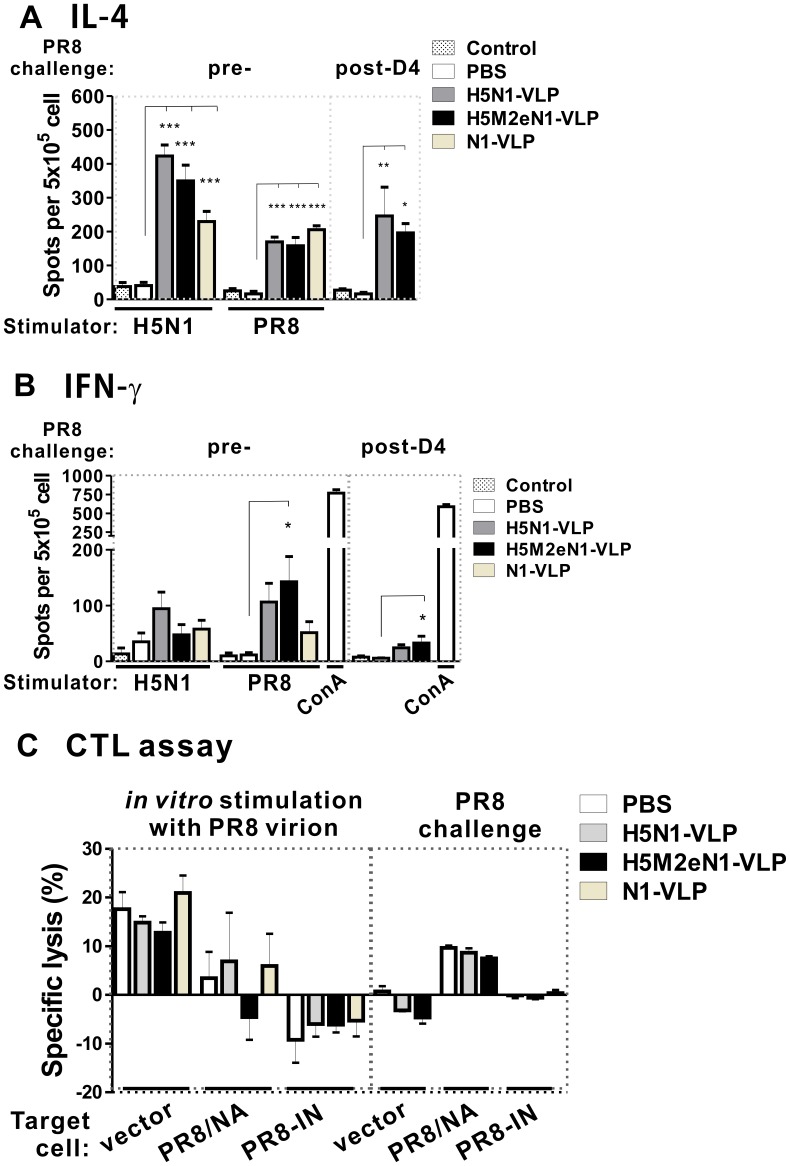
T helper cell responses in VLP-vaccinated mice.The level of IL-4 (A) and IFN-γ (B) spot-forming cells/5×105 in spleens of mice was determined by ELISpot assay. Mice groups (n = 5) were immunized as described in the text either with 15 µg of VLPs vaccines or mock-treated (PBS). Splenocytes were stimulated in vitro with BEI-inactivated whole viruses of H5N1 (10 µg/mL), PR8 (4 µg/mL) or alternatively challenged with PR8 virus for four days (post-D4) as labeled on the top of A and B. The cells were stimulated with ConA (2.5 µg/mL, 1×105 splenocytes/well) as a positive control for IFN-γ ELISpot assay or were mock stimulated as negative control (Control) for both ELISpot assays. Bars represent means ± SEM of spot counts in triplicate wells. Comparing the vaccination and PBS control groups, asterisk indicates statistic significance as used in Figure 1. (C) Cytotoxic T lymphocytes (CTL) responses to VLP vaccinations. Data shown were obtained at an effector/target ratio of 100∶1. Each bar represents the percentage of specific lysis (mean ± SEM). The used autologous target cells (4T1) infected with PR8 (PR8-IN) or either transduced with recombinant lentivirus expressing NA of PR8 (PR8/NA) or wild-type lentivirus (vector) were labeled. The splenocyte effectors prepared from the mice vaccinated with VLP vaccines or mock-treated (PBS) were in vitro stimulated with BEI-inactivated PR8 virion (4 µg/mL) for 5 days or in vivo challenged with PR8 virus for 4 days as indicated.